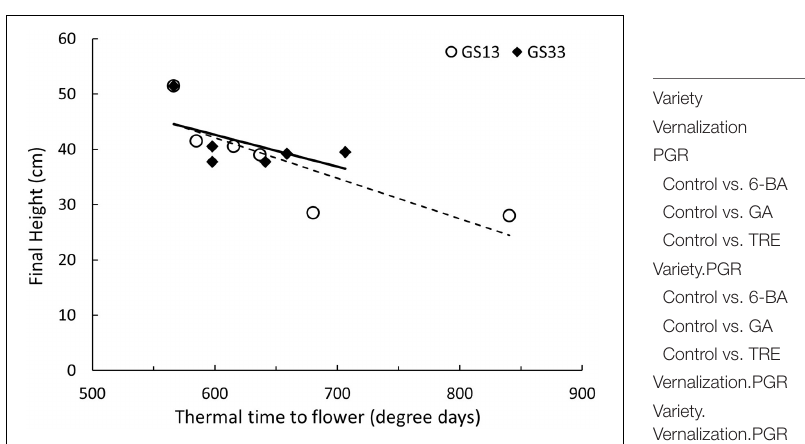
represents a concentration of trinexapac-ethyl with its respective thermal time to flower and final height.